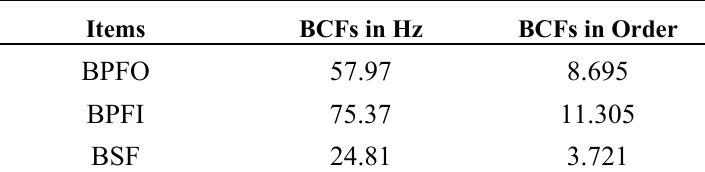
Table 2. BCFs of the